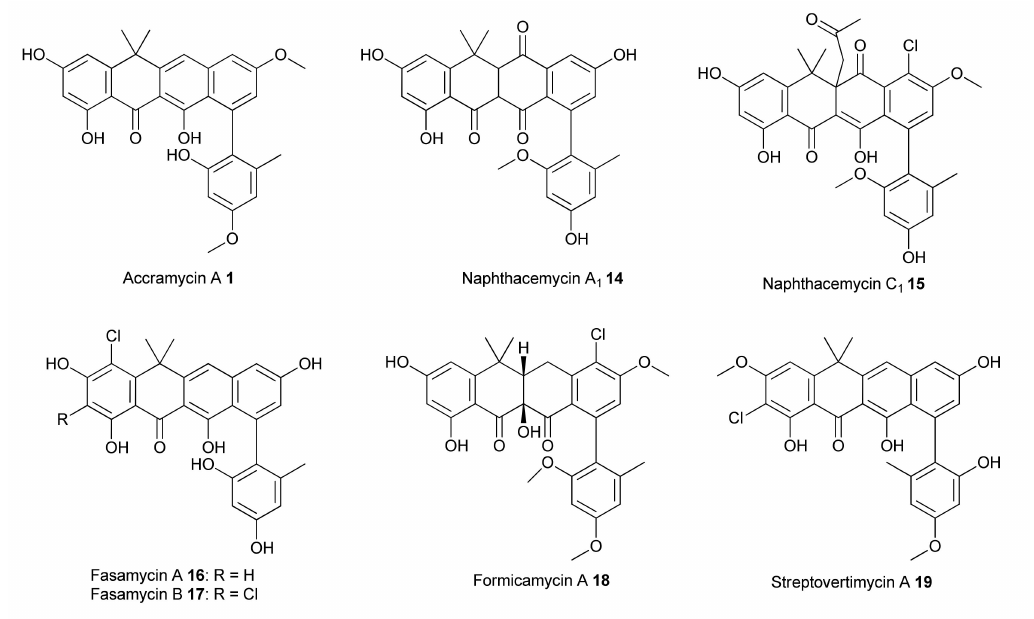
Figure 1. Structures of naphthacemycin-related